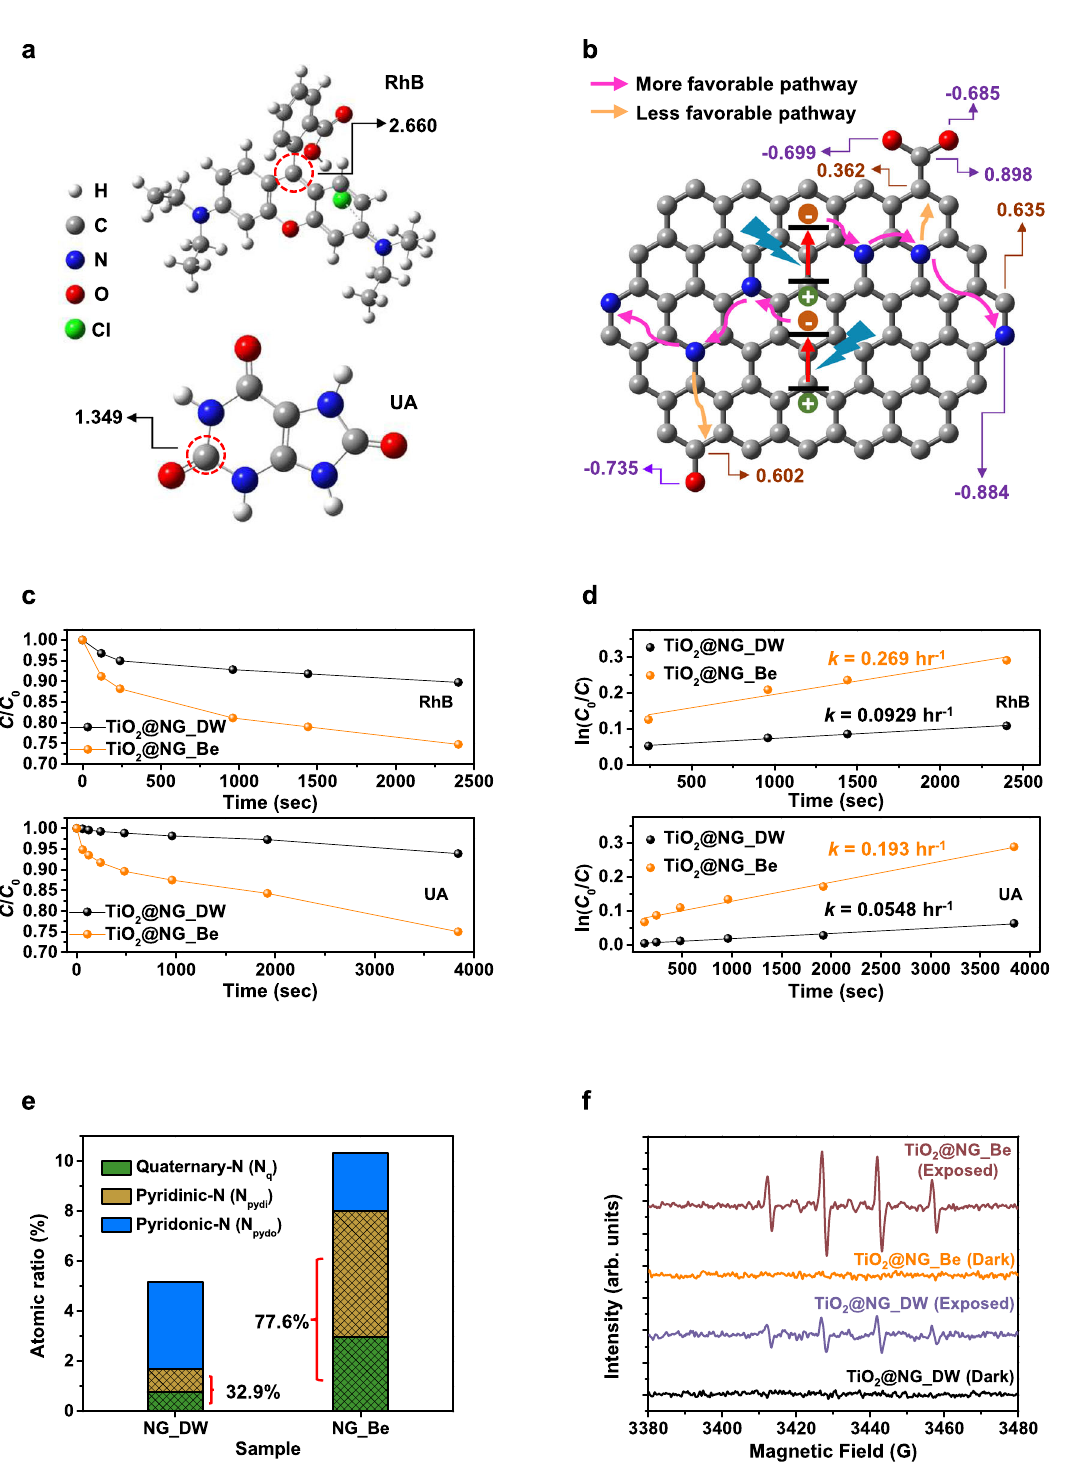
Fig. 5 Photocatalytic activity of NG-decorated TiO 2 composites. a Optimized chemical structures of RhB (top) and UA (bottom). Their local softness values ( s 0 ) were calculated using the NBO analysis. b Calculated local softness values ( s + in brown) of the N-doped graphitic carbon nanostructure. Atomic charges in purple were obtained from the ESP fi tting according to the Merz-Kollman approach at the B3LYP/6-311 + G(d) level. c Photocatalytic degradation of RhB (top) and UA (bottom) in the presence of TiO 2 @NG_DW and TiO 2 @NG_Be catalysts under visible light irradiation ( λ > 400 nm, 38.6 mW cm − 2 ). d First-order kinetics of RhB (top) and UA (bottom) photocatalytic degradation by different photocatalysts. e Chemical compositions of N-containing groups in two types of NGs, obtained from N 1 s XPS spectra. f EPR spectra of photocatalyst in aqueous dispersion for DMPO- (cid:129) OH – under dark and visible light irradiation